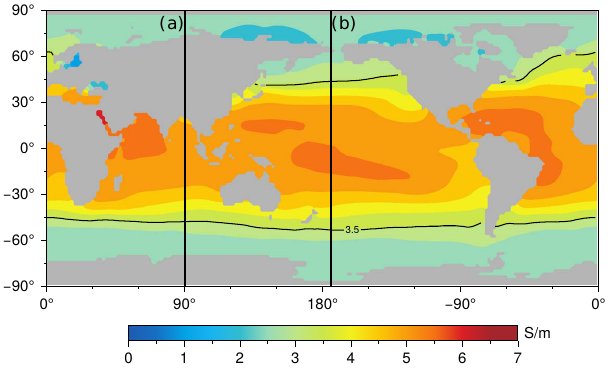
Figure 1. Annual mean seawater conductivity of the upper ocean in Sm − 1 . The black meridional lines indicate the locations of the sections in the Fig. 2a and b. The black contour line indicates the mean conductivity of 3.5Sm − 1